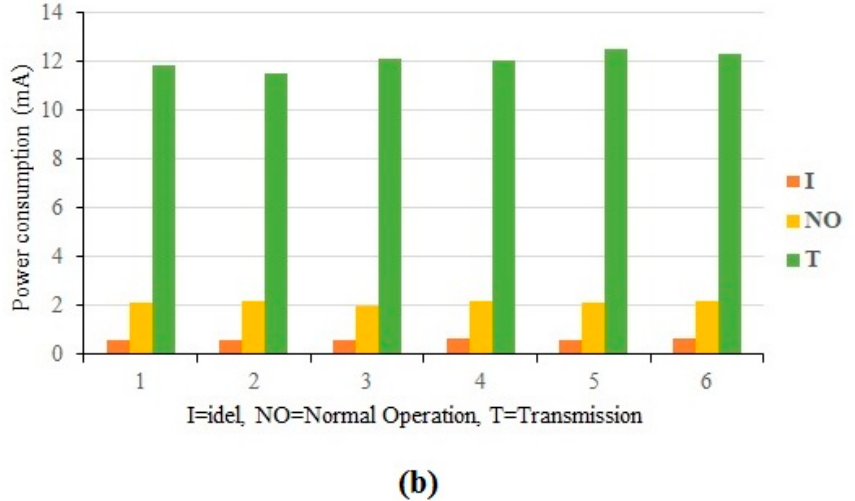
Figure 12. ( a ) Power consumption analysis results of the sensors; ( b ) power consumption analysis results shown in bar chart.